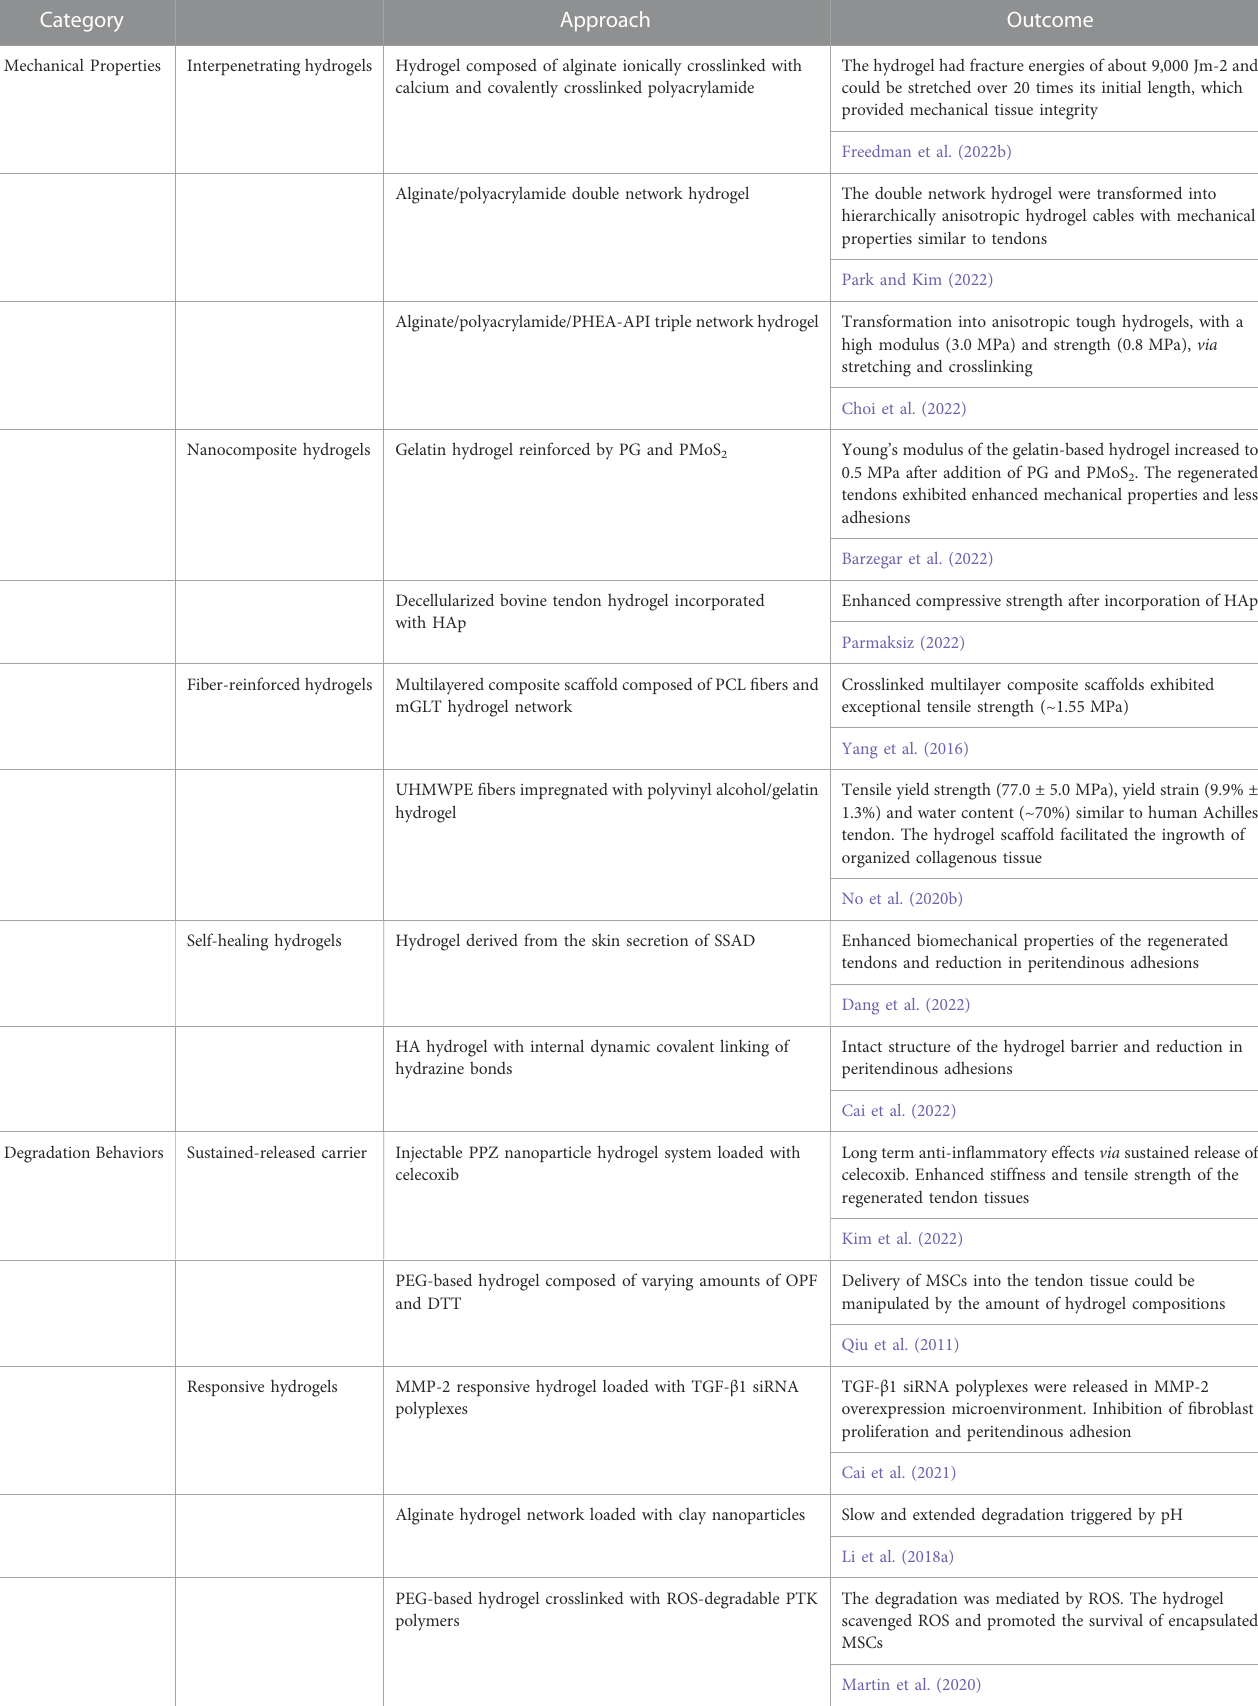
TABLE 1 Mechanical properties and degradation behaviors of hydrogels and their performance in tendon repair.